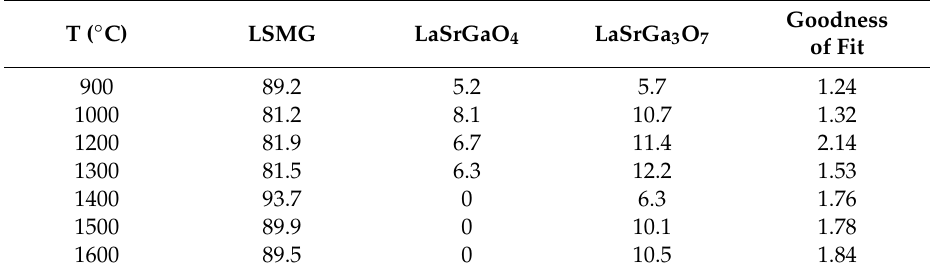
Figure 2. X-ray di ff raction patterns of the LSGM sample showing the evolution with the temperature, ( a ) from room temperature (RT) to 800 ◦ C and ( b ) from 900 to 1600 ◦ C. Table 1. Phase percentage in the LSGM samples after heating at several temperatures, quantified by the Rietveld